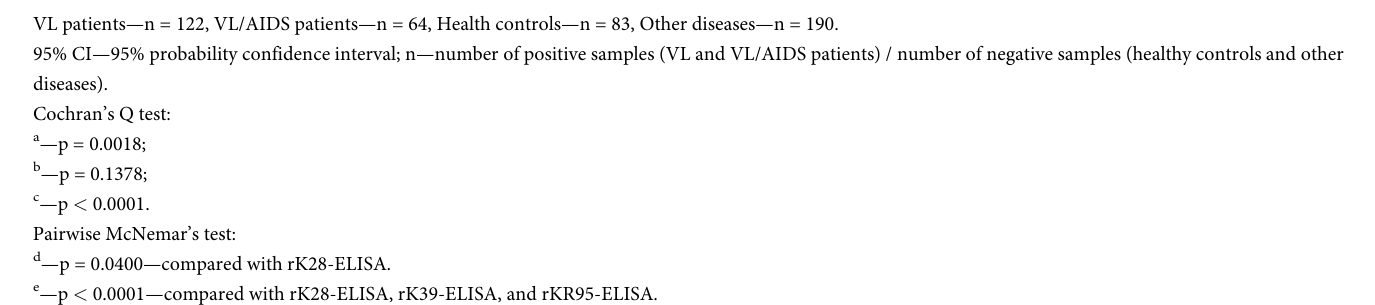
Table 2. Performance obtained by rK18-ELISA, rK28-ELISA, rK39-ELISA, and rKR95-ELISA in sera from VL patients, VL / AIDS patients, healthy controls (Panel 2), and patients with other diseases (Panel 3). Antigens Sensitivity% (n)—95% CI Specificity% (n)—95% CI Diagnostic Odds VL patients a VL /AIDS patients b Healthy controls